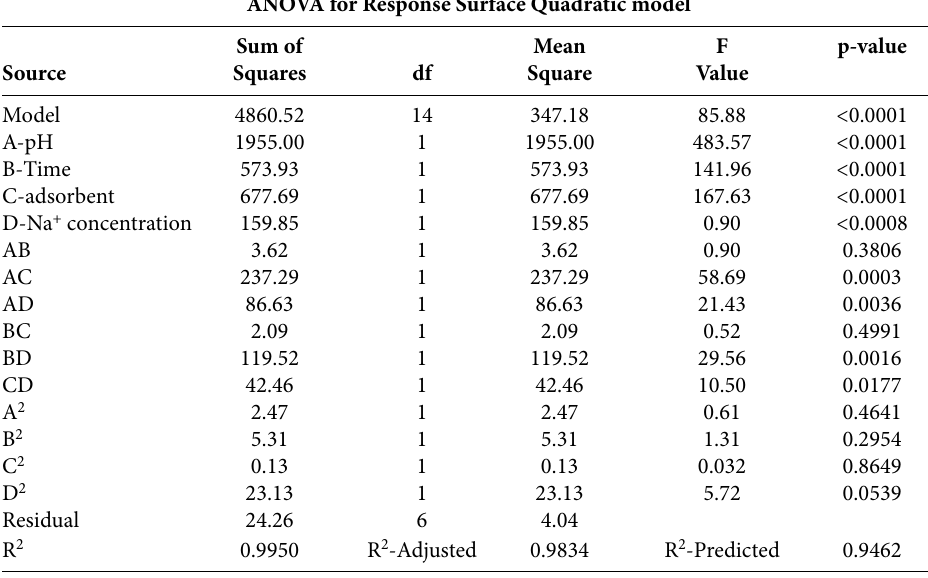
Table 1. Results of the analysis of variance for the studied model ANOVA for Response Surface Quadratic